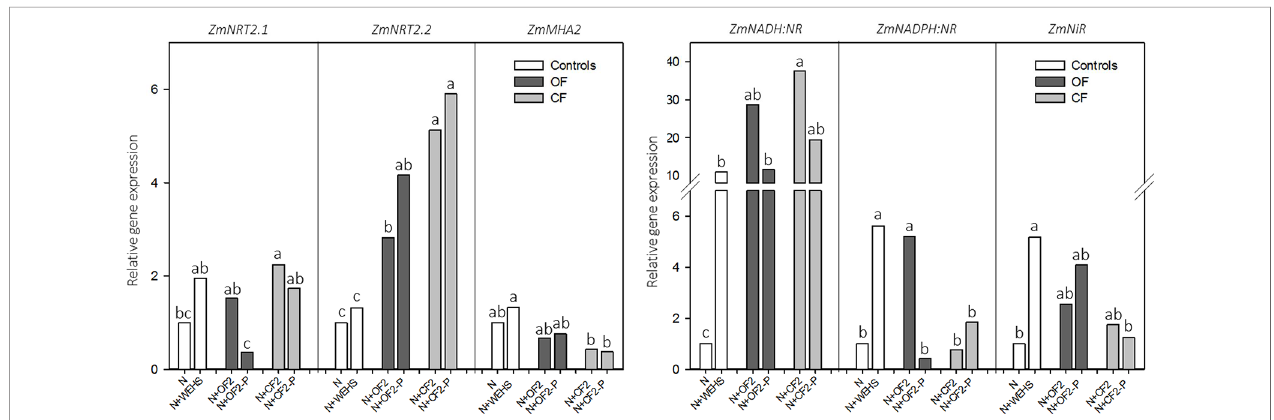
FIGURE 4 | Real-time RT-PCR analyses of the main genes involved in the nitrate acquisition — ZmNRT2.1 and ZmNRT2.2 (coding for two high-af fi nity nitrate transporters), ZmMHA2 (coding for a PM H + -proton pump), ZmNADPH:NR and ZmNADPH:NR (coding for two isoforms of nitrate reductase), and ZmNiR (coding for nitrite reductase) — and performed on roots of maize plants exposed for 2 h to humic substances of different origin isolated in April. White bars , As controls, plants exposed to nutrient solution containing nitrate (0.5 mM Ca(NO 3 ) 2 ) with or without water-extractable humic substances (WEHS) (5 mg C org L − 1 ) ( N+WEHS or N , respectively). Dark gray bars , Plants exposed to nutrient solution with nitrate and dissolved humic substances (DHS) (5 mg C org L − 1 ) isolated from organic farming (OF) soils. Light gray bars , Plants exposed to nutrient solution with nitrate and DHS (5 mg C org L − 1 ) isolated from conventional farming (CF) soils. The code name of samples is reported in Figure 1 . Bars with the same letters are not signi fi cantly different at p ≤ 0.05.